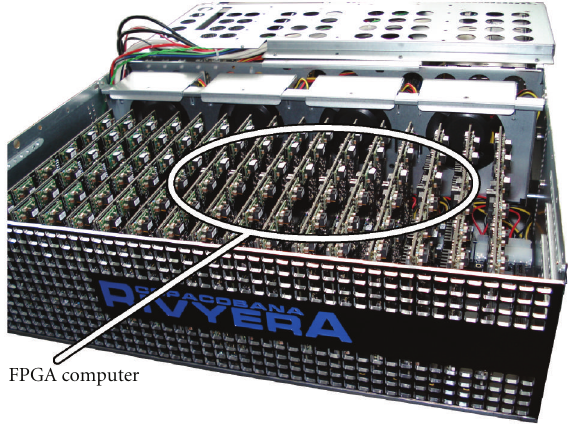
Figure 3: Calculation of f ( R i ) with four